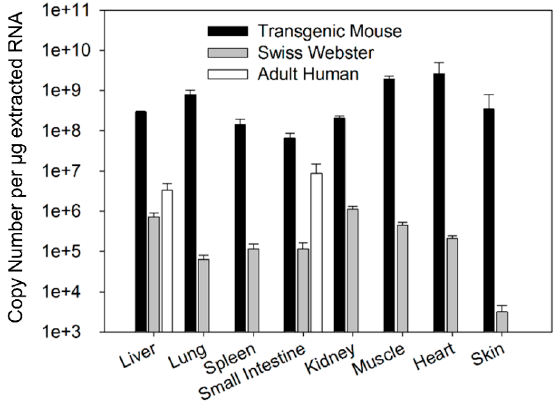
Figure 1. The comparison of FcRn mRNA expression among Swiss Webster mice, transgenic mice, and select human tissues. Data are expressed in terms of copy numbers per µg of extracted RNA. Data are mean ± standard deviation (SD) from 5 Swiss Webster mice, 3 transgenic mice, liver samples from 3 adult human subjects, and small intestine samples from 3 adult human subjects.